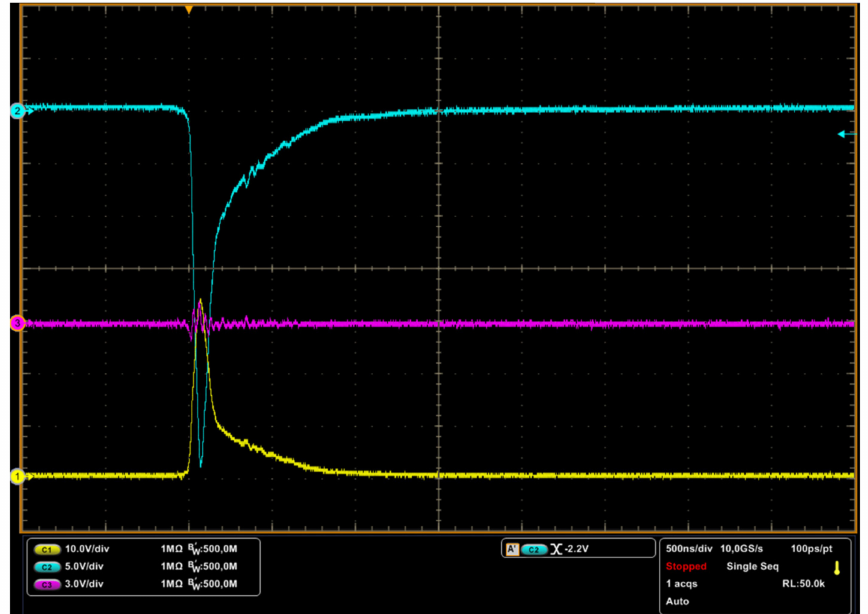
Figure 9. Oscillograms of reverse discharge current from the model antenna (yellow signal), discharge current from the segmented electrodes (cyan signal), and along the radome’s inner surface (magenta signal) (shunts 0.5 Ohm).